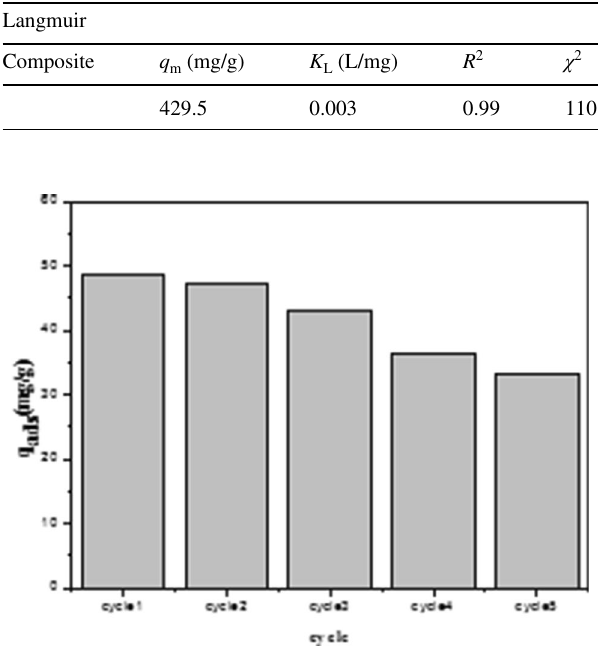
3 , m = 200 mg, 0 = 100 mg/cm